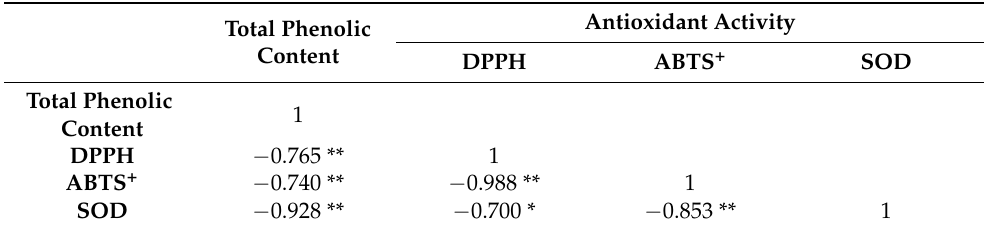
Table 3. Correlation between the total polyphenol content and antioxidant activity of R. emodi fractions.